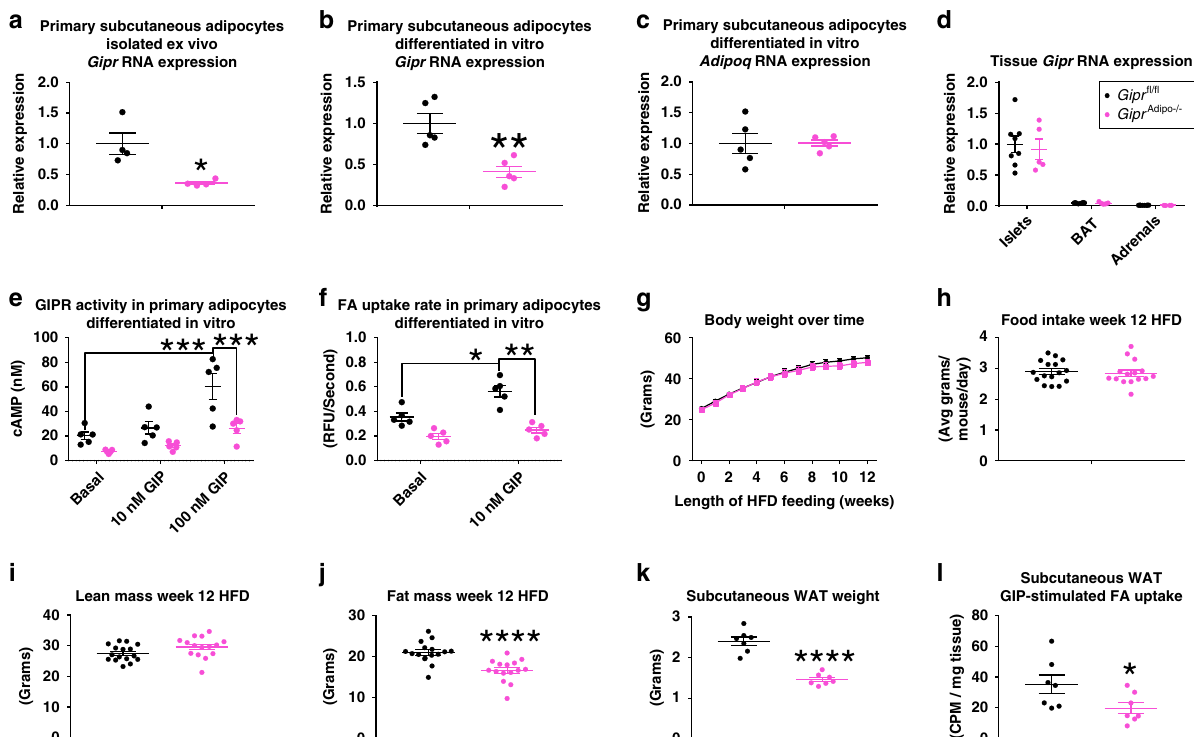
Fig. 5 Mice with adipocyte Gipr knockout have reduced diet-induced fat mass accumulation. a Gipr RNA expression in primary isolated adipocytes from scWAT from male Gipr fl / fl and Gipr Adipo − / − littermates fed HFD for 10 weeks; n = 4 mice/group, Student ’ s paired t test, * p = 0.039. b Gipr and c Adipoq RNA expression in primary mouse pre-adipocytes differentiated in vitro from male Gipr fl / fl and Gipr Adipo − / − littermates fed HFD for 18 weeks; n = 5 mice/ group, Student ’ s paired t test, ** p = 0.0078. d Gipr RNA expression in islets, brown adipose tissue (BAT), and adrenal glands relative to Gipr fl / fl islets from male Gipr fl / fl and Gipr Adipo − / − littermates fed HFD for 18 weeks; n = 8 Gipr fl / fl and n = 5 Gipr Adipo − / − , Student ’ s unpaired t -test. e GIP-stimulated GIPR activity in primary mouse pre-adipocytes differentiated in vitro from male Gipr fl / fl and Gipr Adipo − / − littermates fed HFD for 18 weeks; n = 5 mice, three wells/treatment/mouse, Two-way repeated measures ANOVA with Tukey ’ s HSD for multiple comparisons, Gipr fl / fl /Basal vs. Gipr fl / fl /100 nM *** p = 0.0003 and Gipr fl / fl /100 nM vs. Gipr Adipo − / − /100 nM *** p = 0.0009. f FA uptake rate in primary differentiated mouse pre-adipocytes differentiated in vitro from male Gipr fl / fl and Gipr Adipo − / − littermates fed HFD for 18 weeks. n = 5 mice, three wells/treatment/mouse, two-way repeated measures ANOVA with Tukey ’ s HSD for multiple comparisons, * p = 0.022, ** p = 0.0050. g – j Male Gipr fl / fl and Gipr Adipo − / − littermates fed HFD for 12 weeks and g body weight measured over time, h food intake determined at week 12 HFD feeding, and i lean mass and j fat mass measured by MRI at week 12 HFD feeding. n = 16 Gipr fl / fl mice and n = 15 Gipr Adipo − / − mice, **** p ≤ 0.0001, g two-way repeated measures ANOVA with Sidak ’ s test for